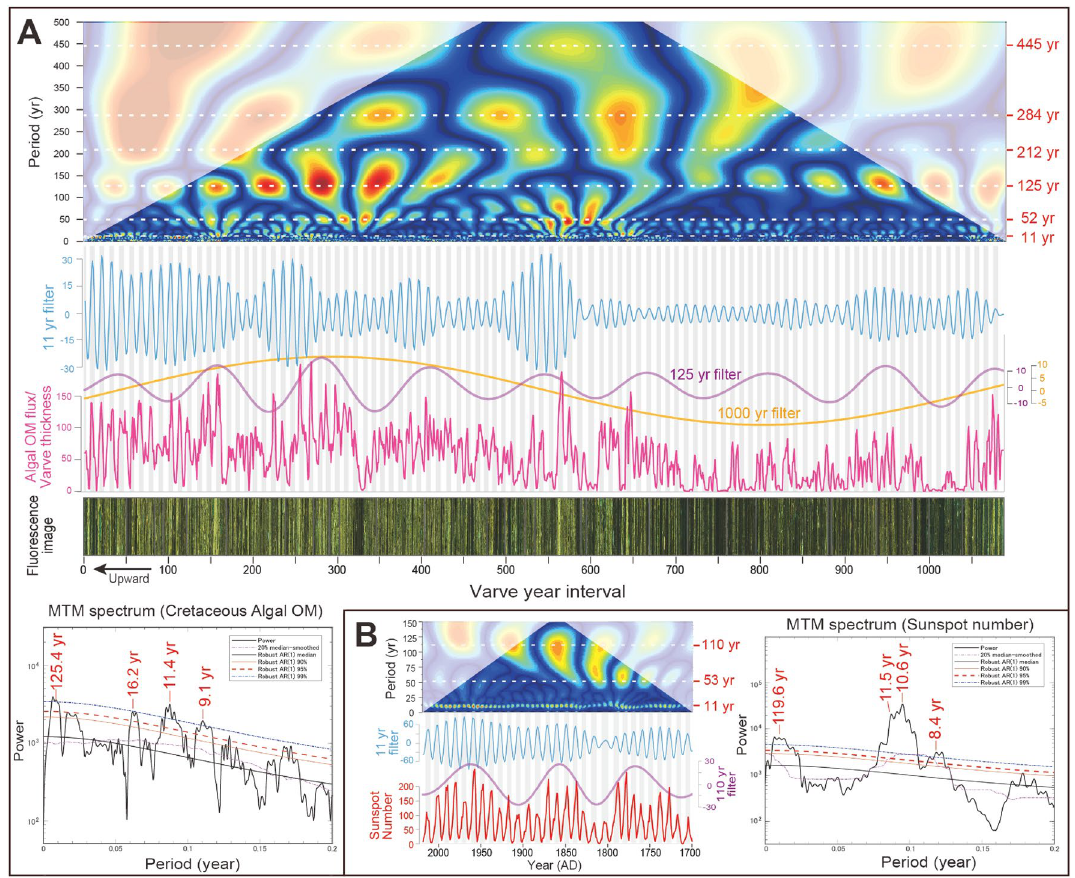
Figure 2. Annually resolved changes in lake algal productivity for a 1091-year interval, compared with modern solar activity. ( A ) Pink line shows the 3-year moving average of changes in algal OM flux, reconstructed from fluorescence intensity and thickness of spring–summer algal OM micro-layers (Figs. S8, S9). Lithology is shown as a reflected fluorescent light image, transformed to temporal variations. The wavelet analysis, MTM spectrum (for 0–500 varve year interval), and AM of 11-year filter (light blue; frequency: 0.089; bandwidth: 0.01), 125-year filter (purple; frequency: 0.008; bandwidth: 0.002), and 1000-year (yellow; frequency: 0.001; bandwidth: 0.0002) filters are also shown. Reddish numbers in MTM spectrum indicate significant spectral peaks above 99% confidential level (CL). Gray vertical bars highlight correlations between changes in lake algal productivity and 11-year cycles. ( B ) Changes in sunspot activity for the past 320 years, with wavelet analysis, 11-year filter (light blue; frequency: 0.0925; bandwidth: 0.01) and 110-year filter (purple; frequency: 0.0091; bandwidth: 0.005), and MTM spectral